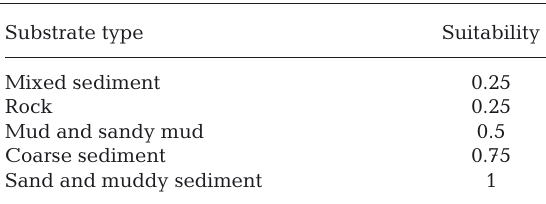
Table 5. Substrate type, reclassified in terms of suitability ranking for all cages (adapted from Beveridge